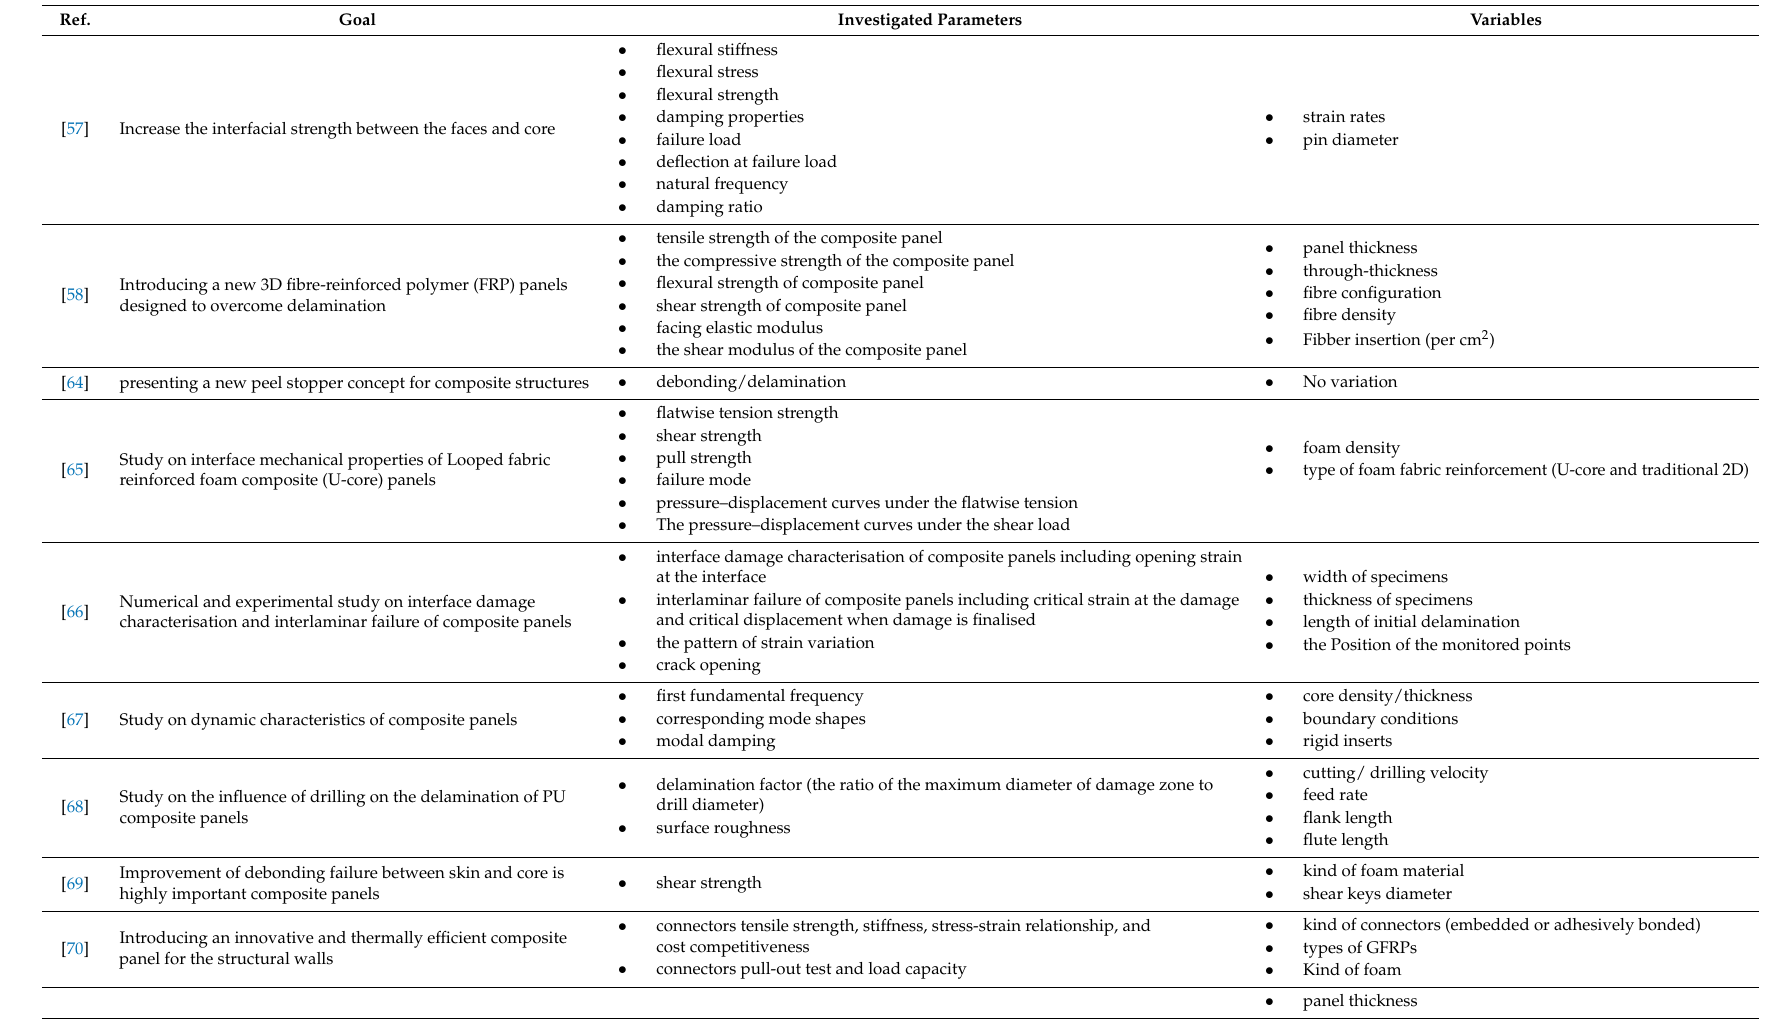
Table 4. Summary of references